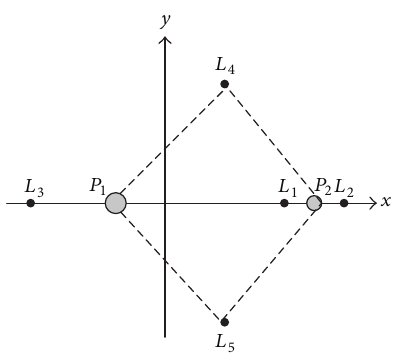
Figure 2: Schematic location of the five Lagrange points in the